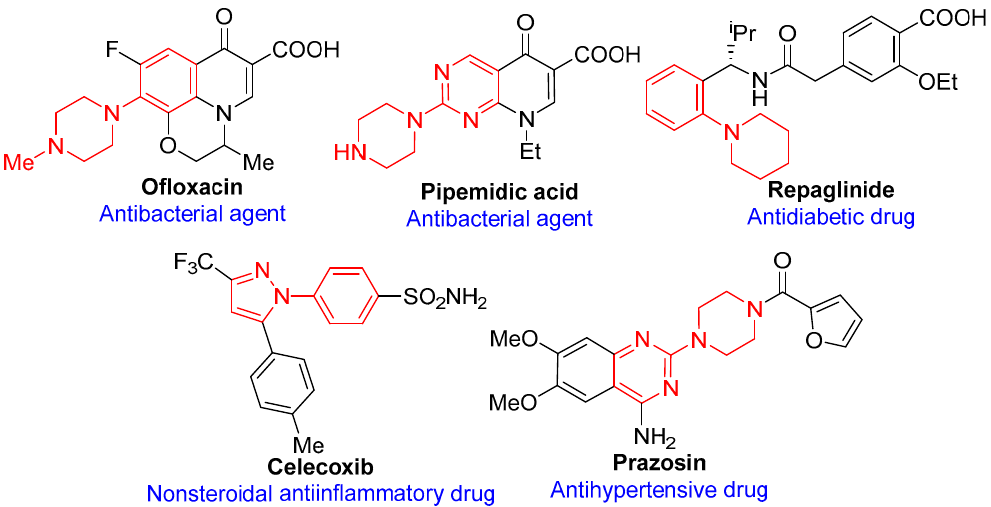
Figure 1. Chemical structures of selected pharmaceuticals containing the N -arylated core.